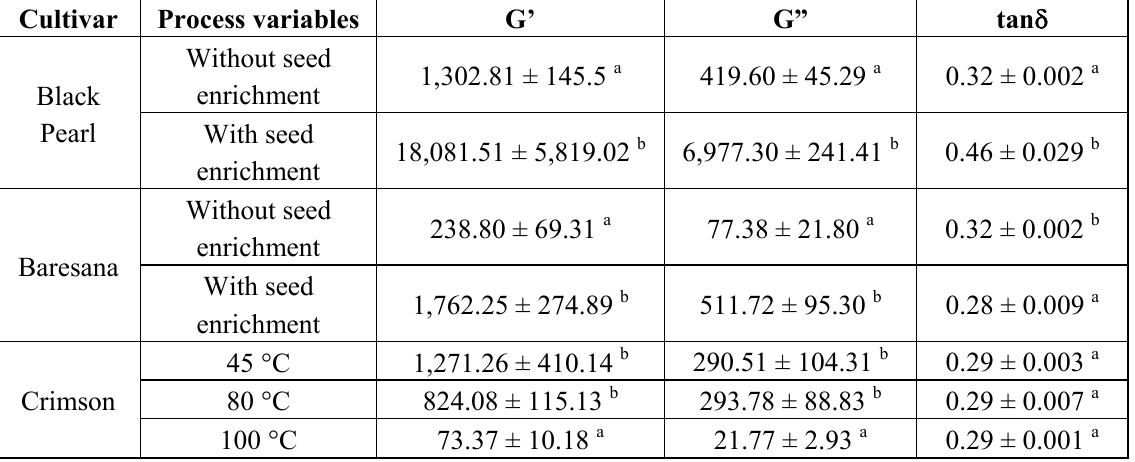
Table 2. Rheological parameters of the functional table grape-based